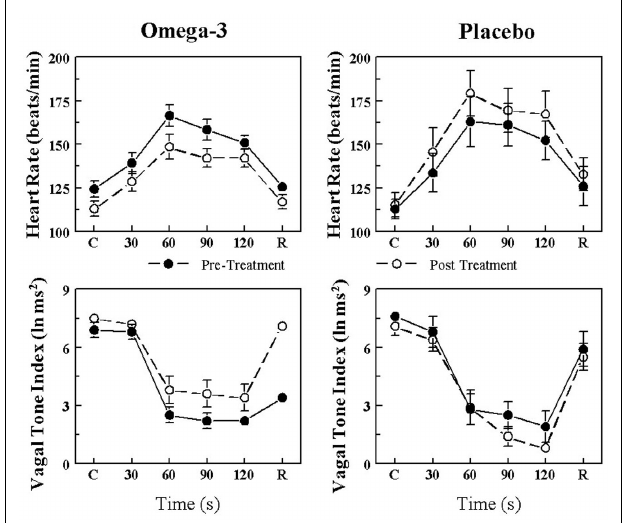
FIGURE 1 | Effect of omega-3 polyunsaturated fatty acids (n − 3 PUFAs) on the heart rate and heart rate variability response to acute myocardial ischemia (2min left circumflex coronary artery occlusion) in dogs susceptible to ventricular fibrillation. Dietary n − 3 PUFA, but not the placebo, produced a significant downward shift of the heart rate (HR) response that was accompanied by an upward shift in the high